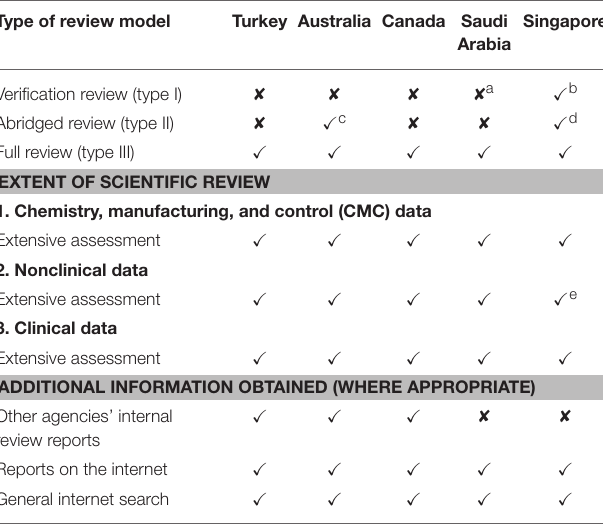
TABLE 1 | Models of assessment of the five agencies and extent of the scientific